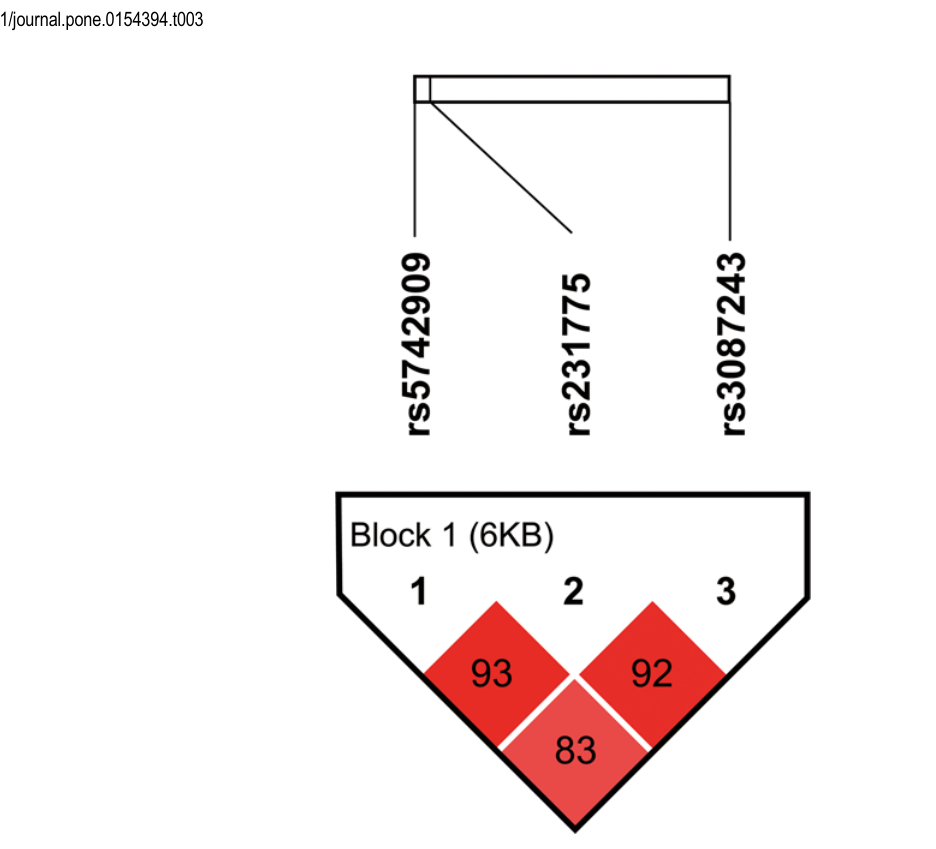
Fig 1. Linkage disequilibrium (LD) plot in 1058 controls. The ticks on the uppermost white bar denote the genotyped SNPs and their relative sites. The SNP pairwise information is plotted as boxes between these ticks. The number in the box denotes the D' value between each pair of SNPs. The intensity of the box color is proportional to the strength of the LD. The block is generated by solid spine of LD method in Haploview 4.2.